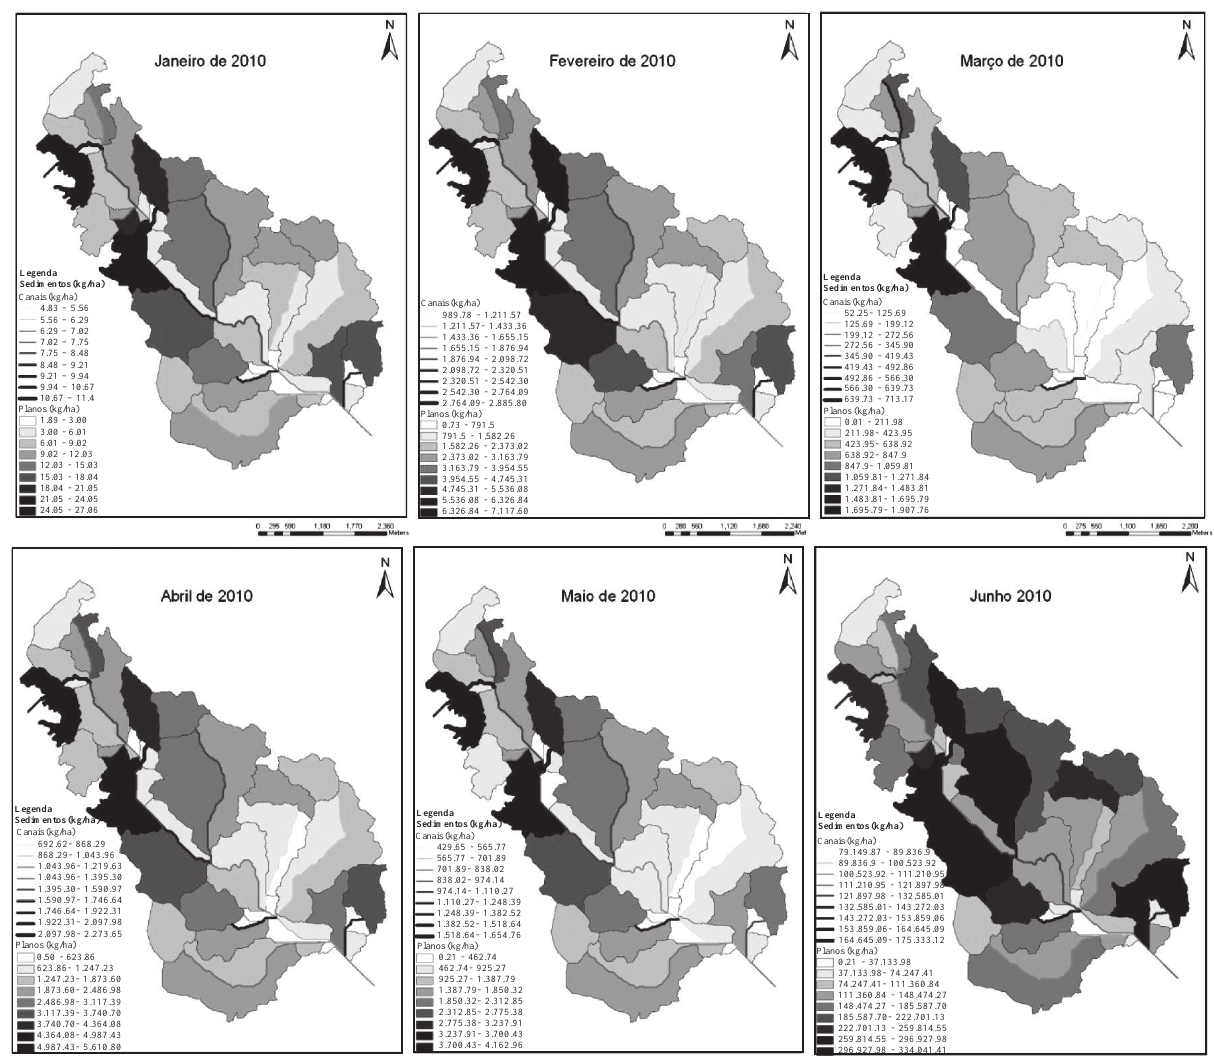
Figura 3. Espacialização da produção média calculada de sedimentos para a bacia do rio Jacarecica, de janeiro a junho de